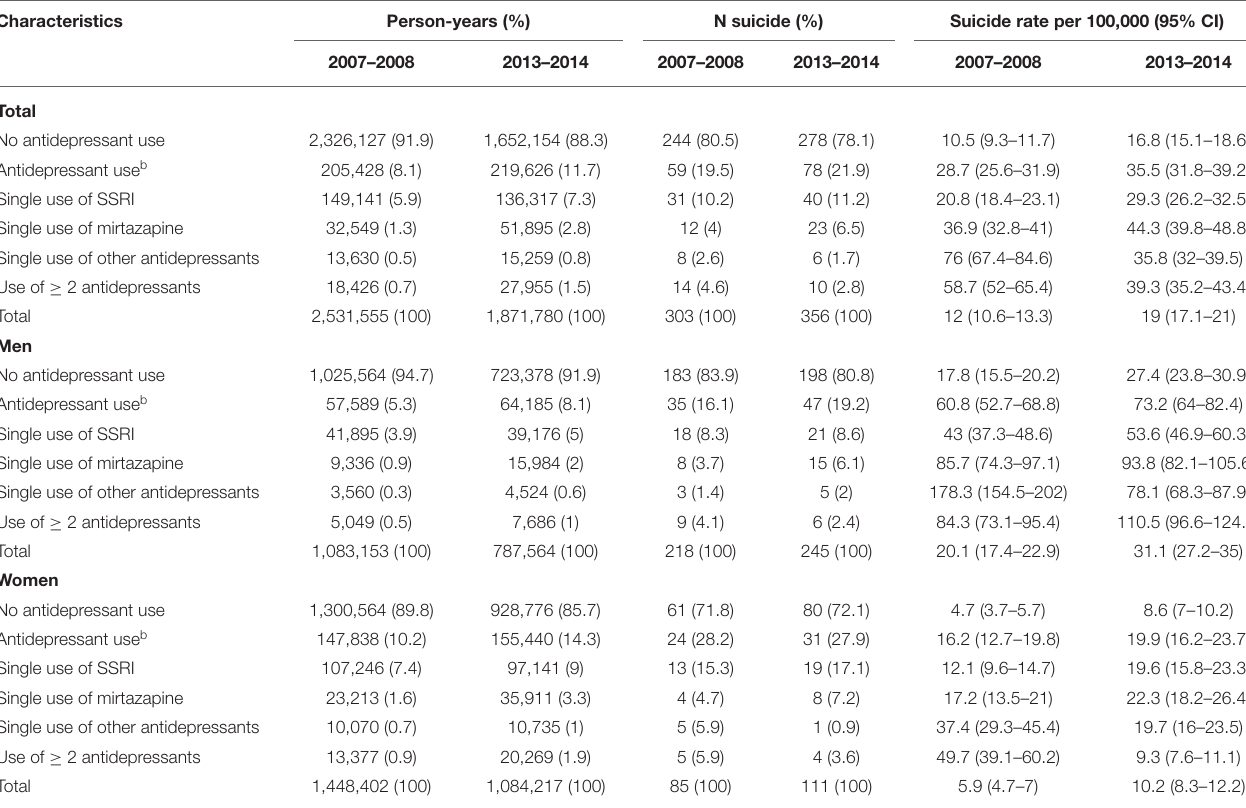
TABLE 3 | Distribution of biannual suicide rate per 100,000 person-years by antidepressant treatment group among persons aged 75 and above residing in Sweden a for 2007–2008 and 2013–2014.